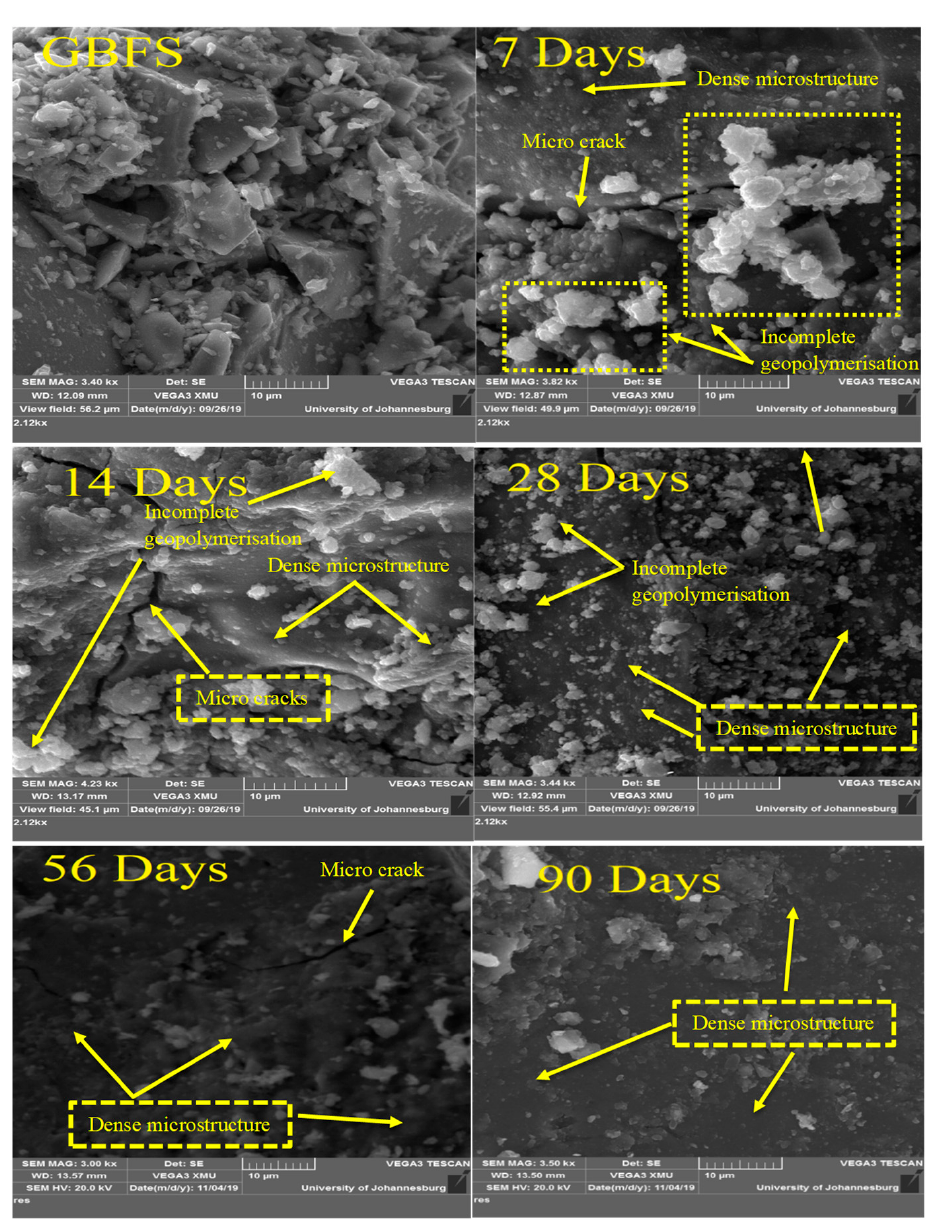
Figure 7. SEM micrographs of GGBFS and samples cured at ambient temperature for different days.